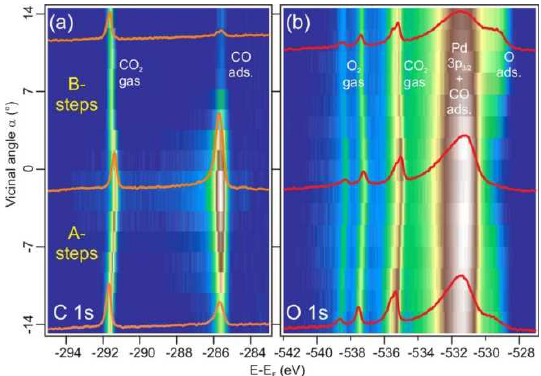
Fig. 1. C1s (a) and O1s (b) intensity plots across the curved surface at 485K, during reaction cooling-off. In (a), the strong variation of the chemisorbed CO indicates that the reaction is poisoned at the sample center, becoming more active towards the A side and fully active at the B edge. Reprinted with permission from [26]. Copyright (2018) American Chemical Society.